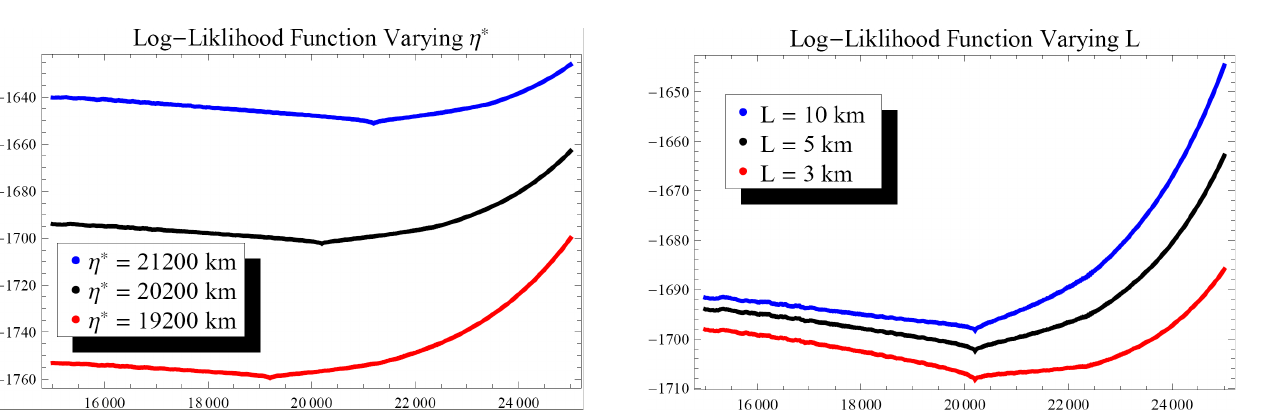
Fig. 6. Negative log-likelihood function as a function of η 1 in km, for varying turbulence length